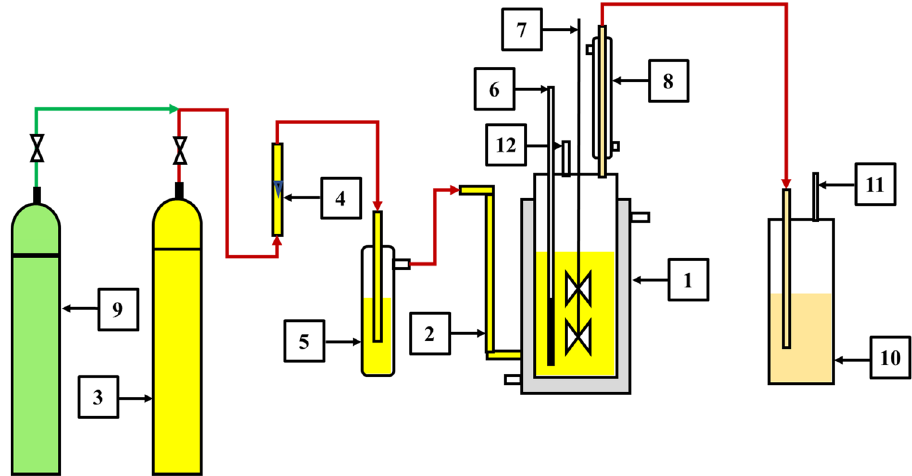
Figure 1: Schematic of experimental test setup: ( 1 ) jacketed cylindrical glass reactor, ( 2 ) chlorine gas inlet, ( 3 ) chlorine gas cylinder, ( 4 ) rotameter, ( 5 ) sulfuric acid trap, ( 6 ) temperature sensor, ( 7 ) stirrer, ( 8 ) re fl ux condenser, ( 9 ) nitrogen gas cylinder, ( 10 ) caustic scrubber, ( 11 ) vent, and ( 12 ) para ffi n/LDPE/solvent charge